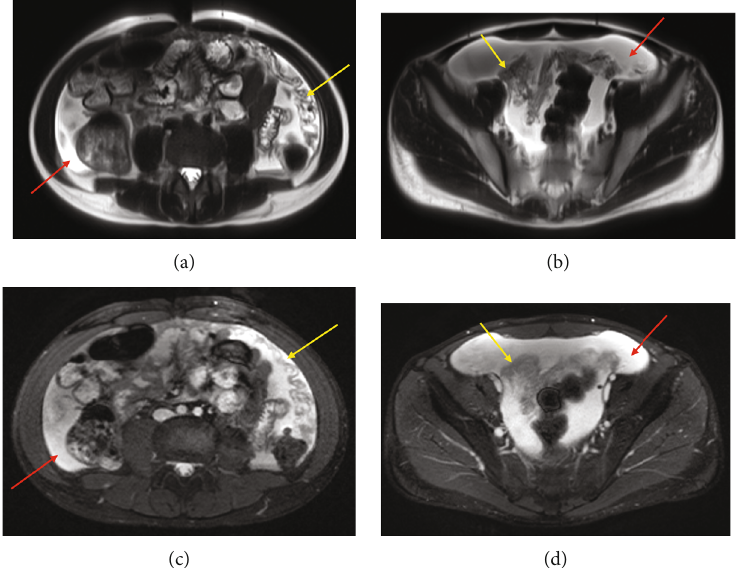
Figure 1: (a, b) Axial T2 images of the midabdomen and pelvis showing ascites (red arrows) and peritoneal thickening (yellow arrows). (c, d) Axial T2 fat-saturated images of the midabdomen and pelvis showing ascites (red arrows) and peritoneal thickening (yellow arrows).